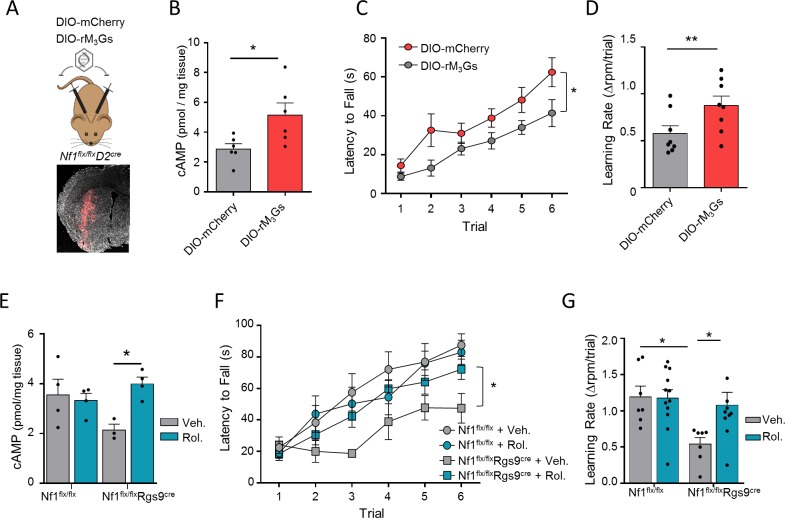
Chemogenetic and pharmacological rescue of motor deficits associated with NF1 deficiency.(A) Scheme and Image of Nf1flx/flxD2cre mice bilaterally injected in the striatum with AAV-DIO-rM3Gs. Mouse graphic was adapted from [44]. (B) Quantification of striatal cAMP levels of Nf1flx/flxD2cre bilaterally injected with AAV-DIO-rM3Gs or DIO-mcherry upon CNO administration. n = 6 mice/group. (C) Increase in performance and (D) learning rate on the accelerating rotarod of DIO-rM3Gs mice compared with DIO-mcherry mice following CNO injection in Nf1flx/flxD2cre mice. n = 6–7 mice/group. (E) Quantification of striatal cAMP levels in Nf1flx/flx and Nf1flx/flxRgs9cre treated with rolipram. (F) Performance and (G) learning rate on the rotarod task for Nf1flx/flx and Nf1flx/flxRgs9cre mice treated with rolipram. n = 7–10 mice/group. Two-way RM ANOVA. *P < 0.05, **P < 0.01. Data are represented as mean ± SEM. Underlying data for this figure can be found in S1 Data. DIO, double-floxed inverted open reading frame; NF1, neurofibromin 1; RM-ANOVA, repeated measures analysis of variance; Rol, rolipram; Veh, vehicle.